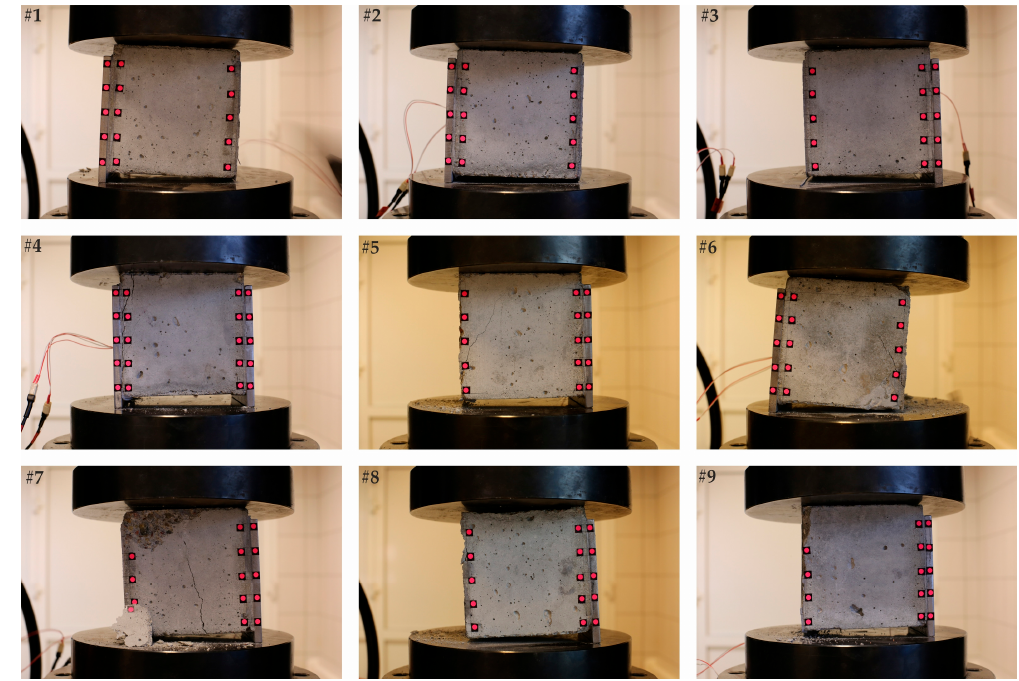
Figure 6. Failure modes of tested steel-concrete specimens (last stage in the testing machine): mode I including specimens #1 to #3 —adhesive failure and mode II including specimens #4 to #10 —cohesive-type failure or mixed cohesive-adhesive failure.